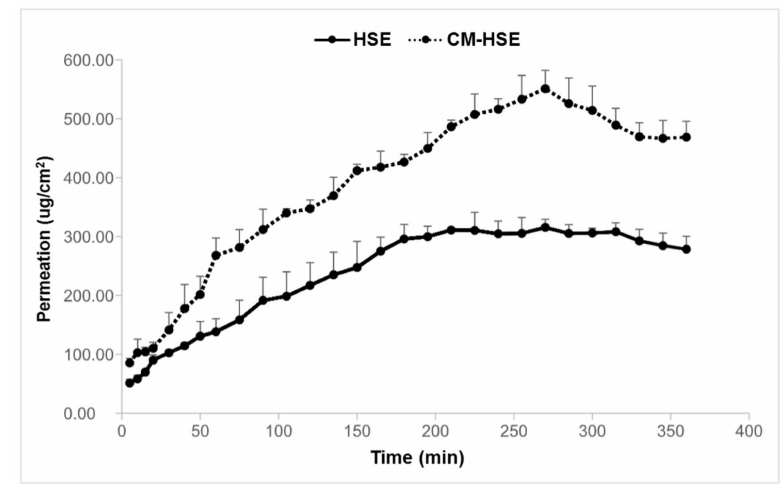
Figure 10. Results of in vitro permeation study of HSE and CM-HSE through Franz